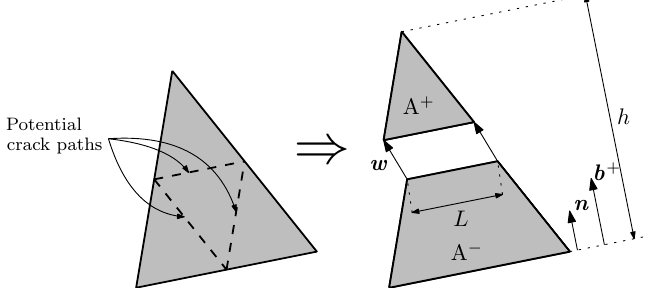
Figure 4. Potential crack paths ( left ) and geometrical definitions of w , n , and b + ( right ). Once the crack direction is defined, the element is divided into two parts, A + and A − , and the stress vector t is constant along the crack, expressed by